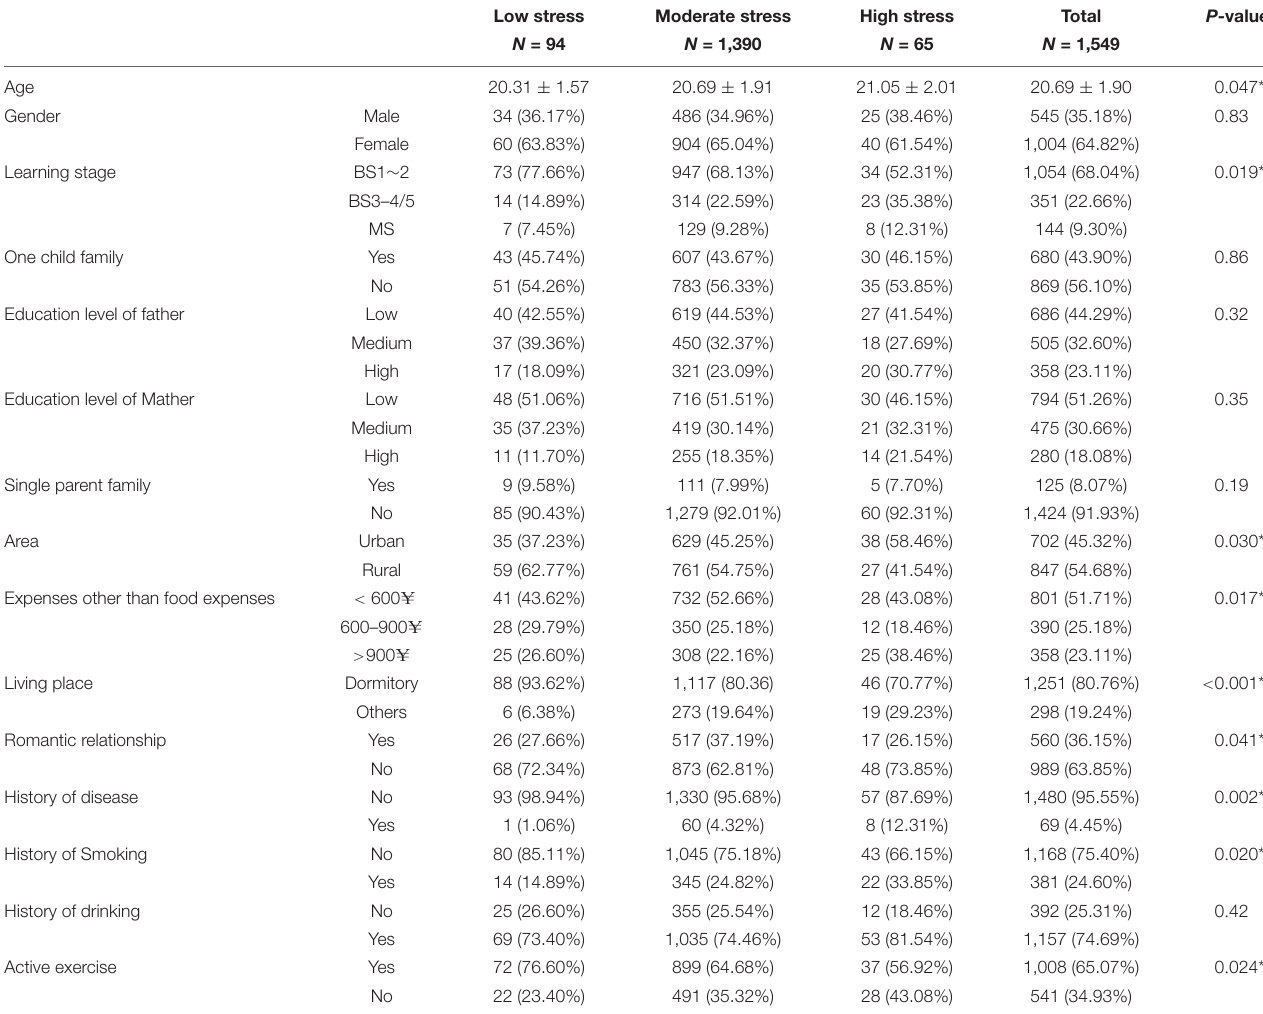
TABLE 1 | Characteristics of